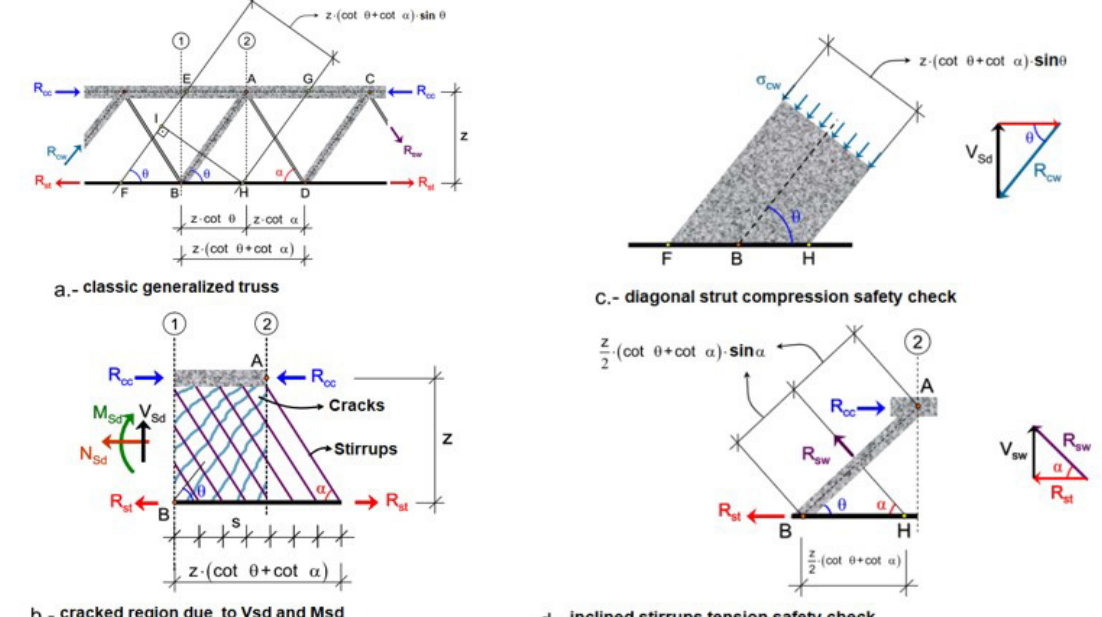
Figure 3: Generalized truss model with parallel chords